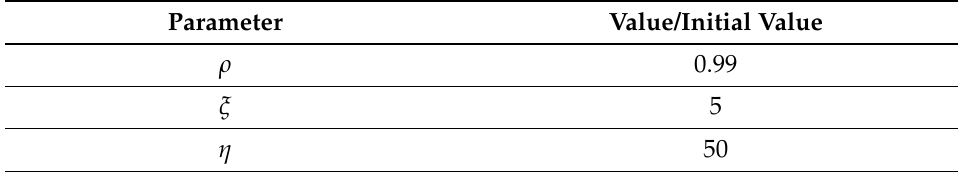
Table 2. Parameters and initial values of the experiments.